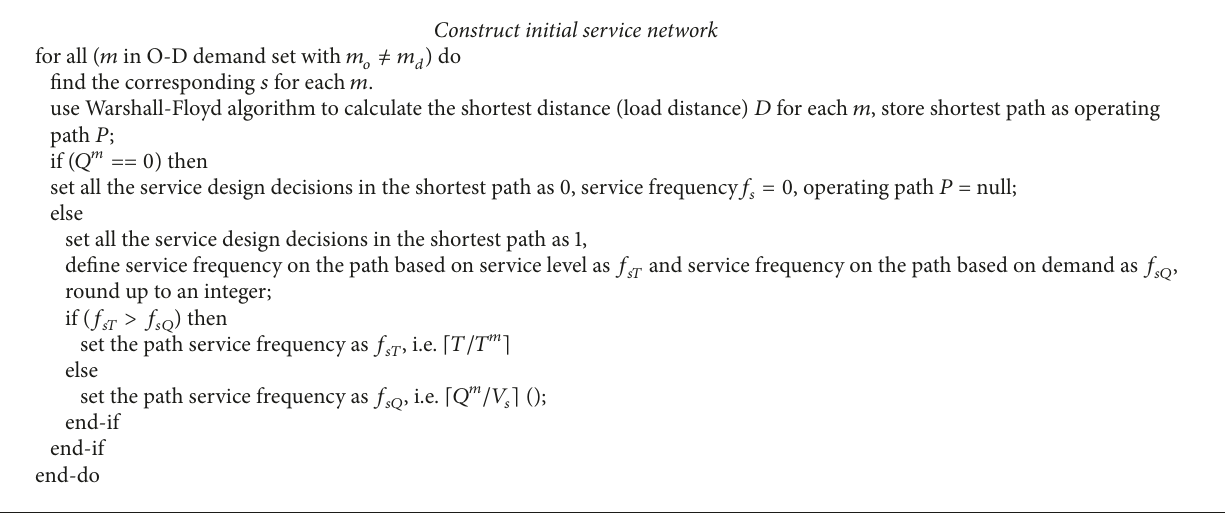
Pseudocode 1: Pseudocode for initial service network construction. Select Service Path